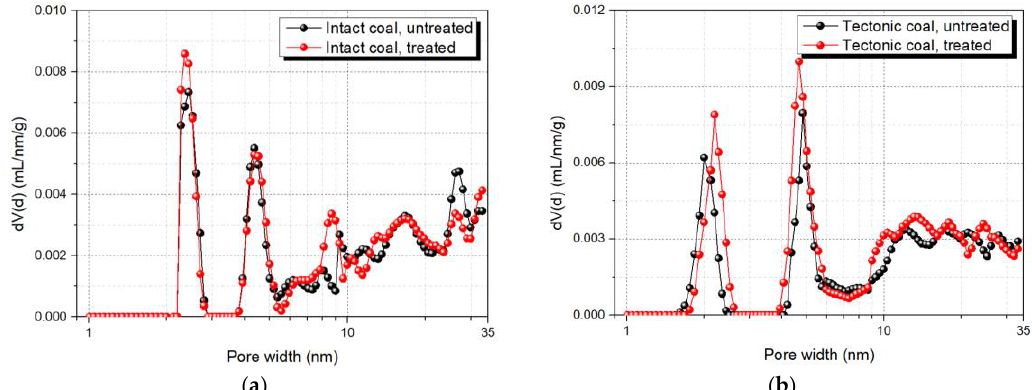
Figure 6. Pore size distributions of the untreated and ScCO 2 -treated coal samples as determined by the density functional theory (DFT) analyses of N 2 (77 K) adsorption isotherms for ( a ) intact coal and ( b ) tectonic coal.